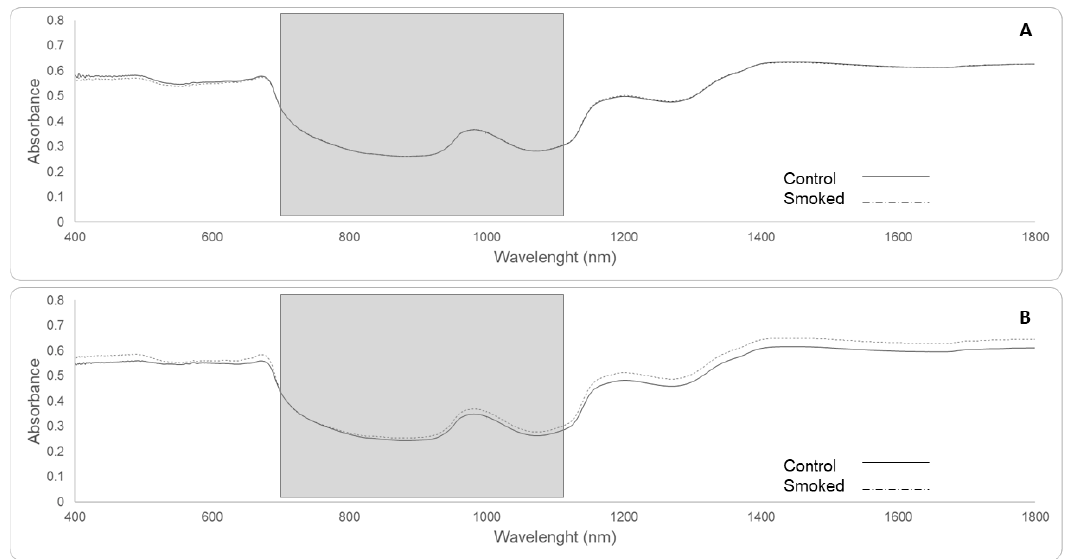
Figure 7. Average spectra for control (solid line) and smoke-affected berries (dashed line) from red cultivars ( A ): Merlot, Shiraz, Pinot Noir, Cabernet Sauvignon and white cultivars ( B ): Pinot Gris, Chardonnay and Sauvignon Blanc. The grey rectangles represent the wavelengths used for machine learning fitting modeling (700–1100 nm), with the main peak at 982 nm.